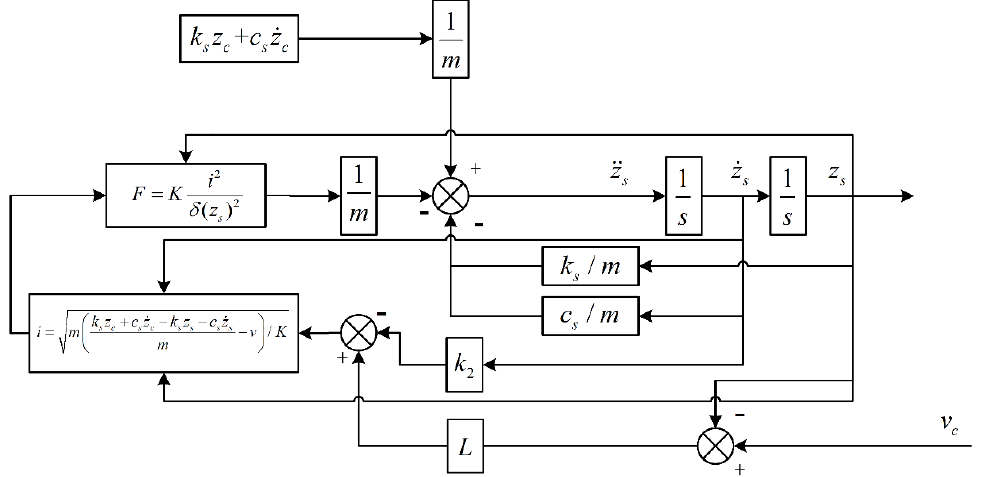
Figure 7. Structure block diagram of state feedback control system.